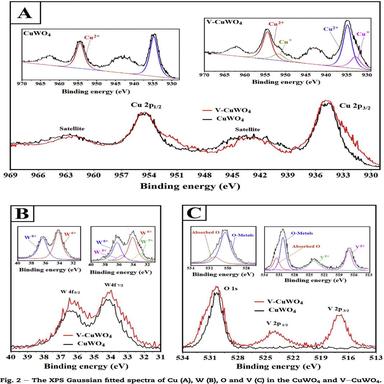
UVeVis absorption spectra of CuWO4 and VeCuWO4.